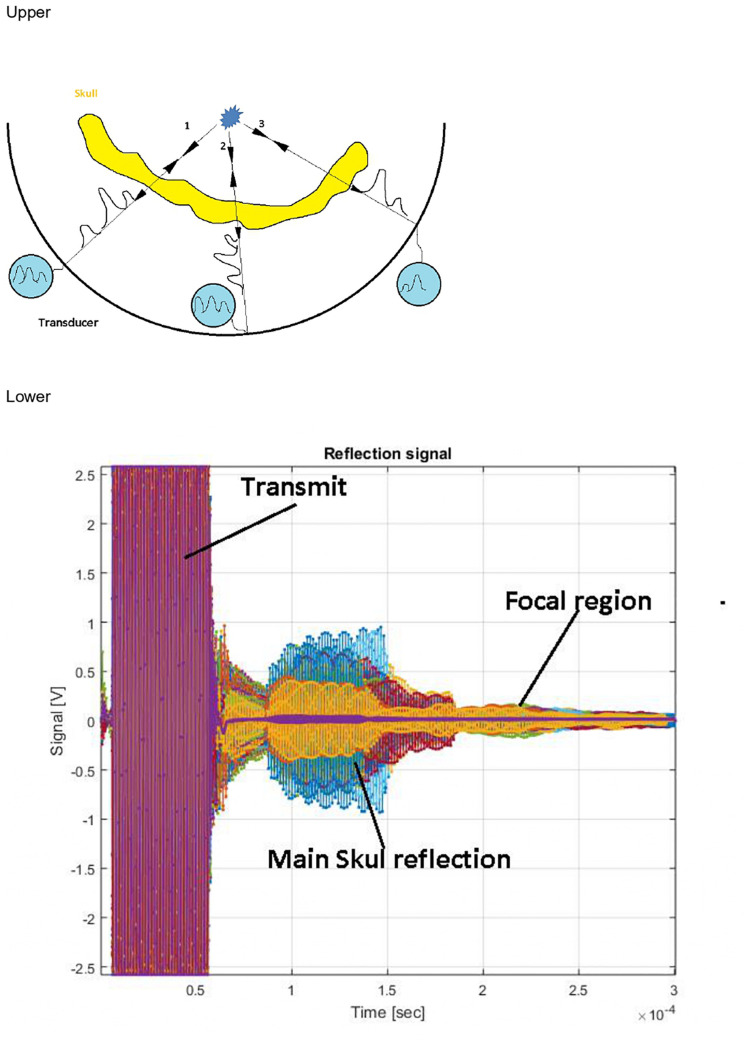
Upper: Ultrasound contrast agent microbubbles emit a spherical wave as a point scattering source. Aberration corrections are deduced directly from the measurement. Lower: Typical recorded signal. Different colors represent different channels. Multiple reflections from the skull dominate the signal. The microbubble signal is invisible at this scale.